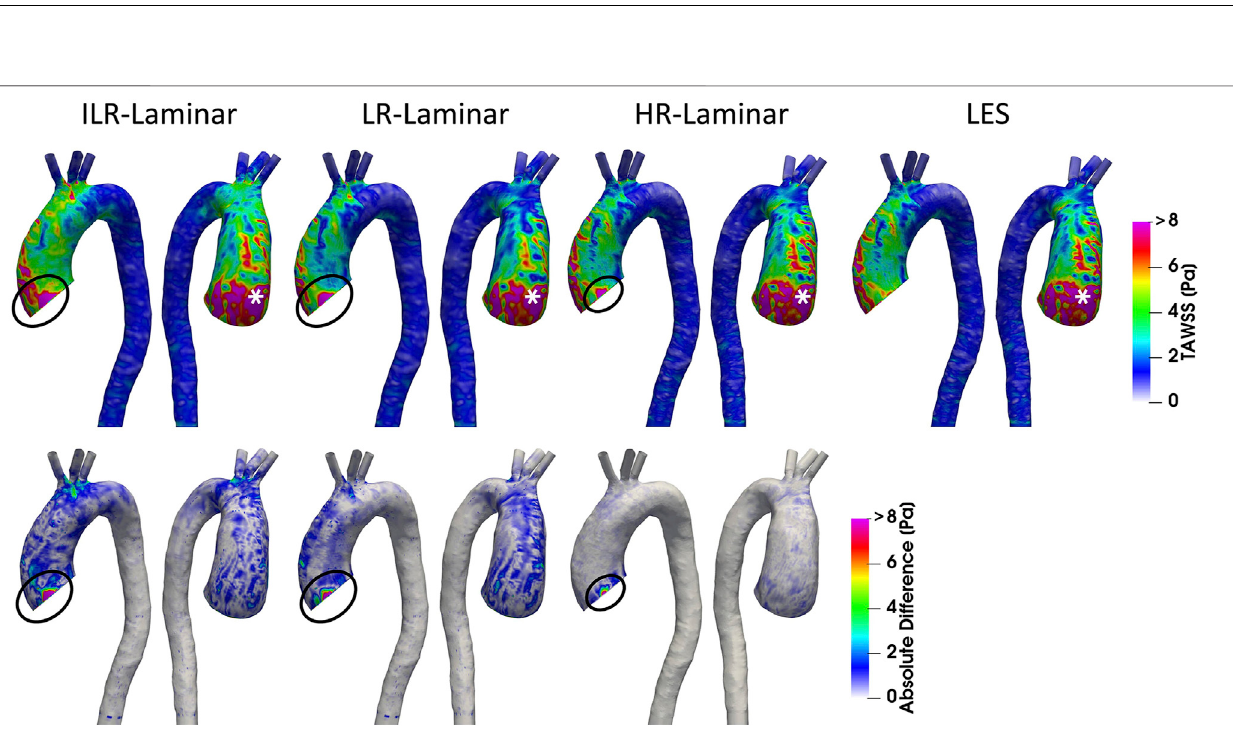
FIGURE 5 | Top row: Time-averaged wall shear stress (TAWSS) contours for ILR-Laminar, LR-Laminar, HR-Laminar and LES simulations. Bottom row: Absolute difference in TAWSS values for ILR-, LR- and HR-Laminar simulations, relative to the LES simulation. Locations of interest are circled and asterisked.